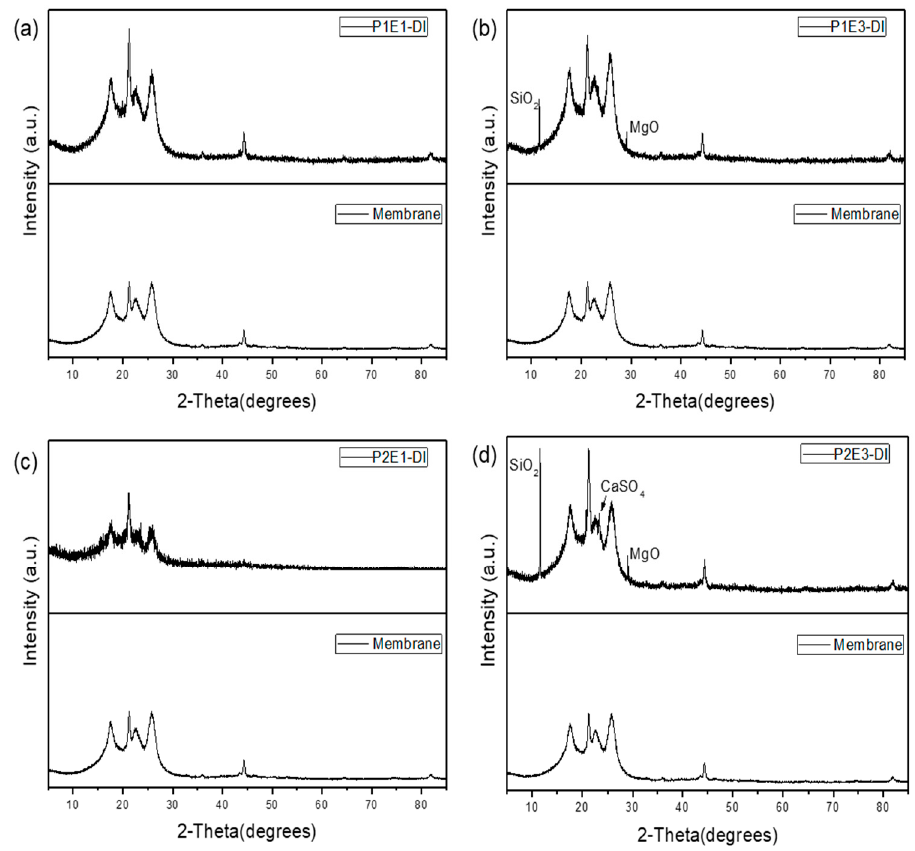
Figure 8. X-ray diffraction (XRD) of deionized water rinsed RO membranes. ( a ), Phase 1 Element 1, DI water rinsed (P1E1-DI); ( b ), Phase 1 Element 3, DI water rinsed (P1E3-DI); ( c ), Phase 2 Element 1, DI water rinsed (P2E1-DI); ( d ), Phase 2 Element 3, DI water rinsed (P2E3-DI).